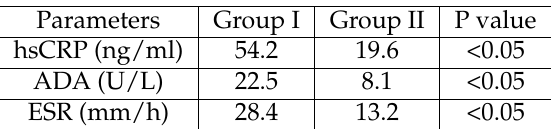
Table 2. Assessment of